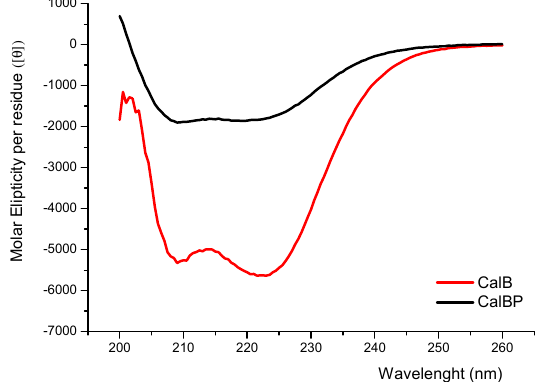
Figure 4. Circular dichroism spectra of CAL-B enzymes. CAL-B ( red ), glycopolymer-CAL-B ( black ).